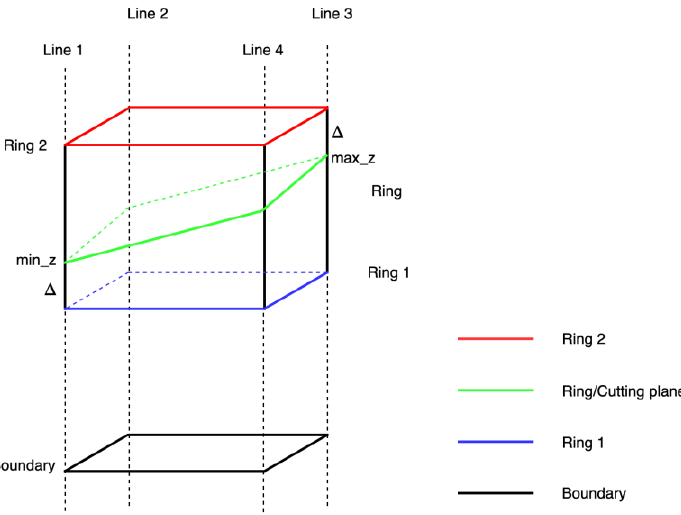
Figure 7. Illustration for boundary, ring 1, ring 2, ring, and the cutting plane.